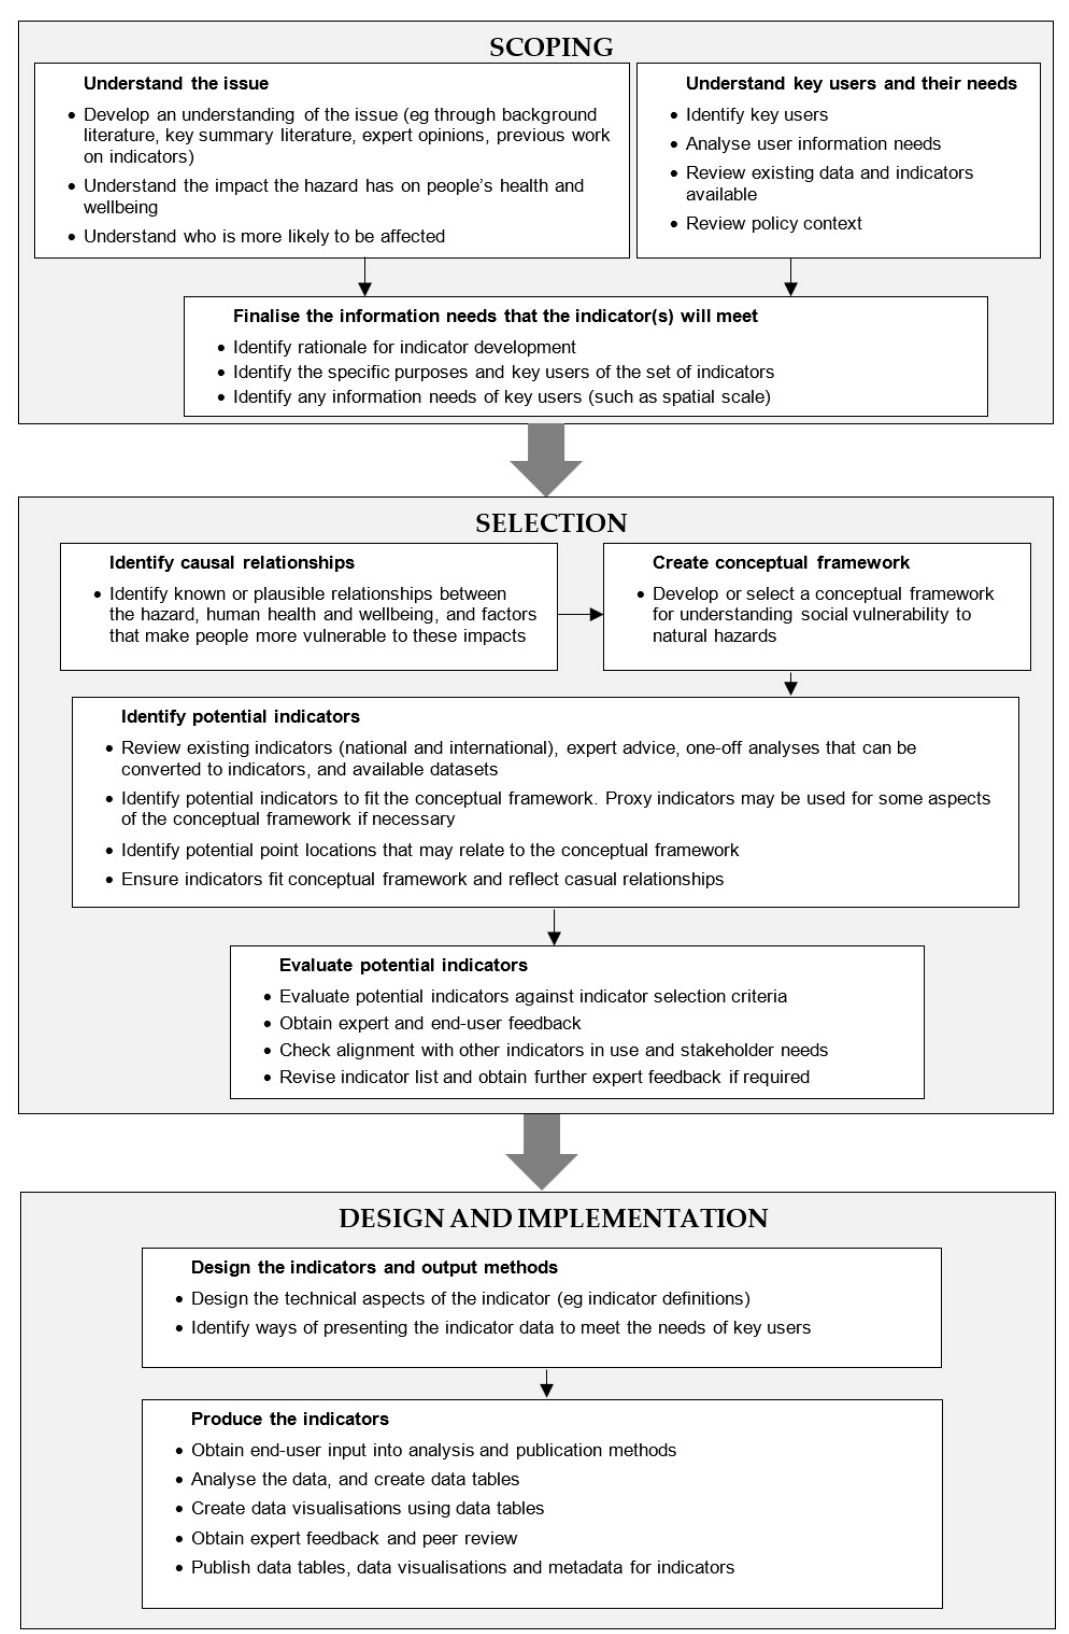
Figure 2. Social vulnerability indicator development process (adapted from Mason et al. [52]).